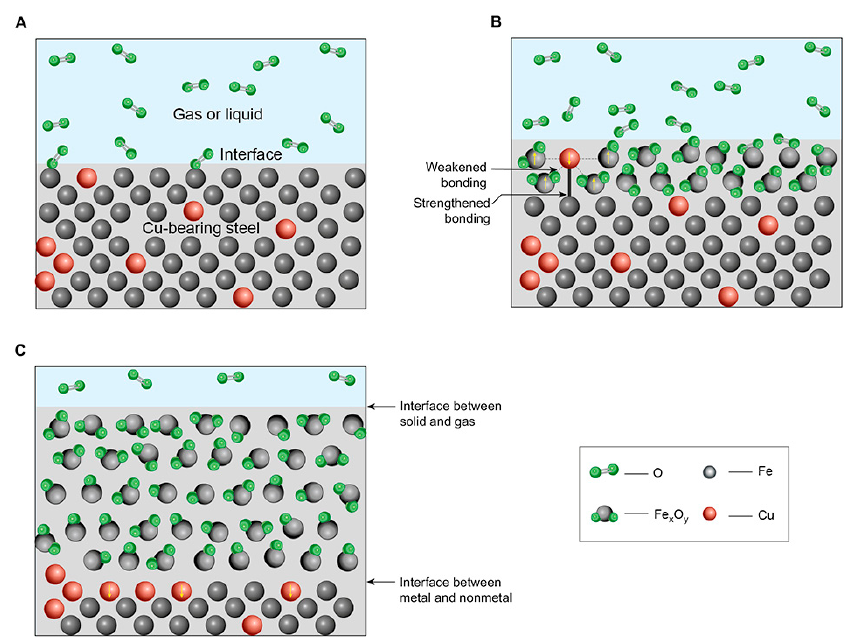
Figure 6. Schematic diagram of copper enrichment mechanism.